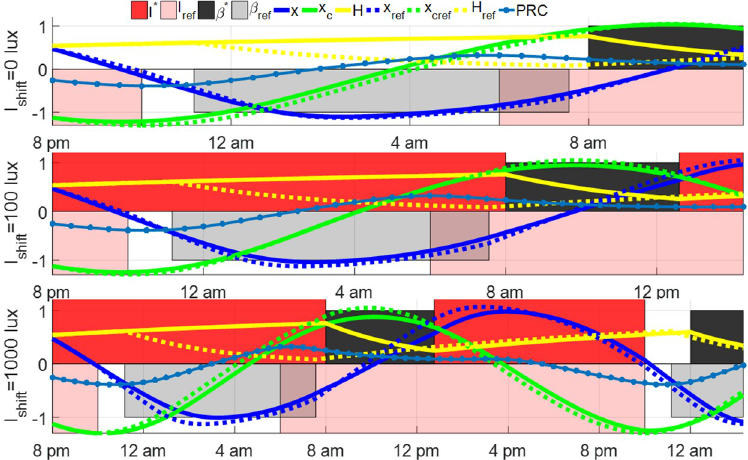
Fig 13. Open-loop entrainment with different night shift light intensity I shift . The solid curves show the time courses of the entraining state of night shift workers, and the dashed curves show the time courses of the reference state. The open-loop entrainment time is 3.46 hours for I shift = 0 lux, 6.29 hours for I shift = 100 lux and 18.32 hours for I shift = 1000 lux. The blue dot line shows the phase response curve (PRC) of the entraining state.